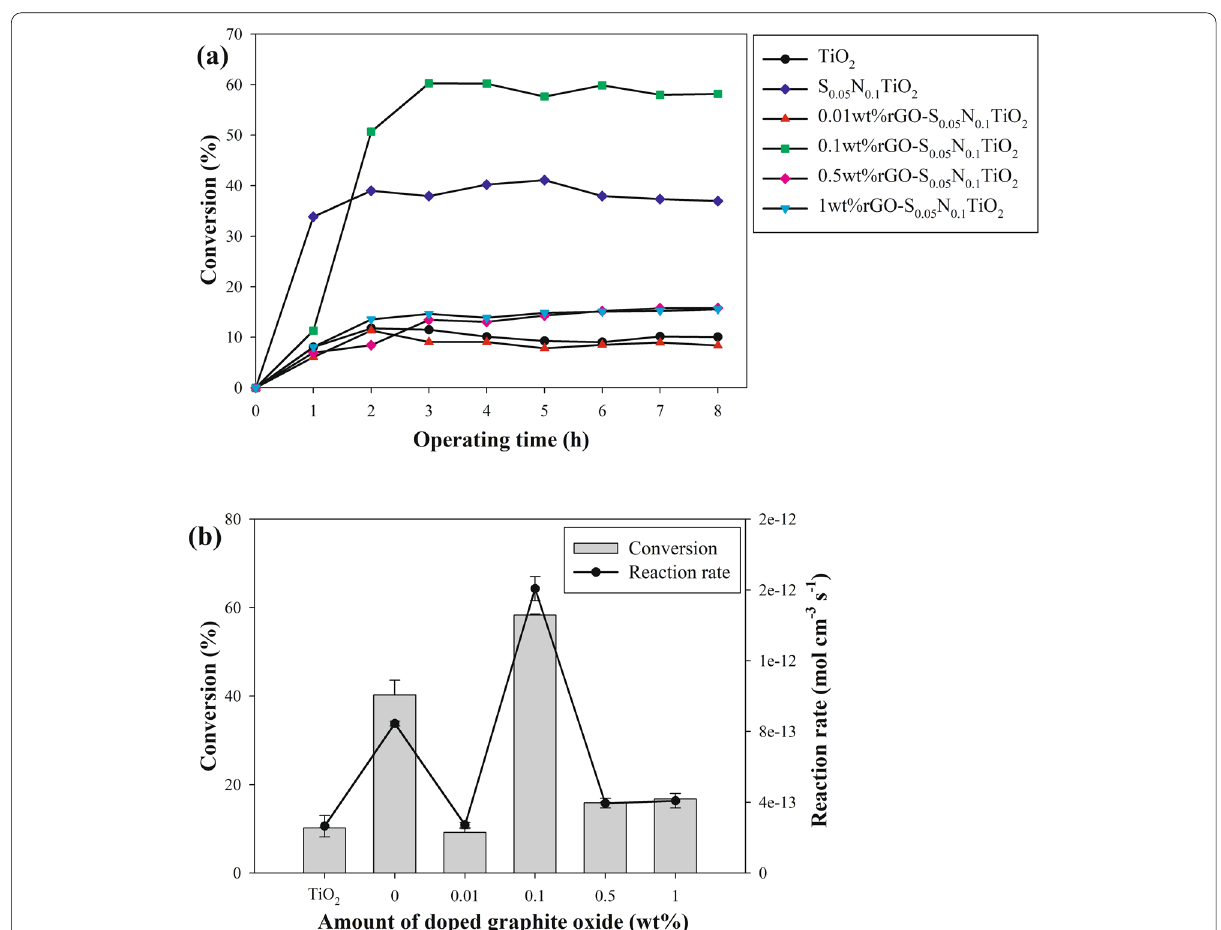
Fig. 6 ( a ) conversion and ( b ) reaction rate value during the toluene photocatalytic